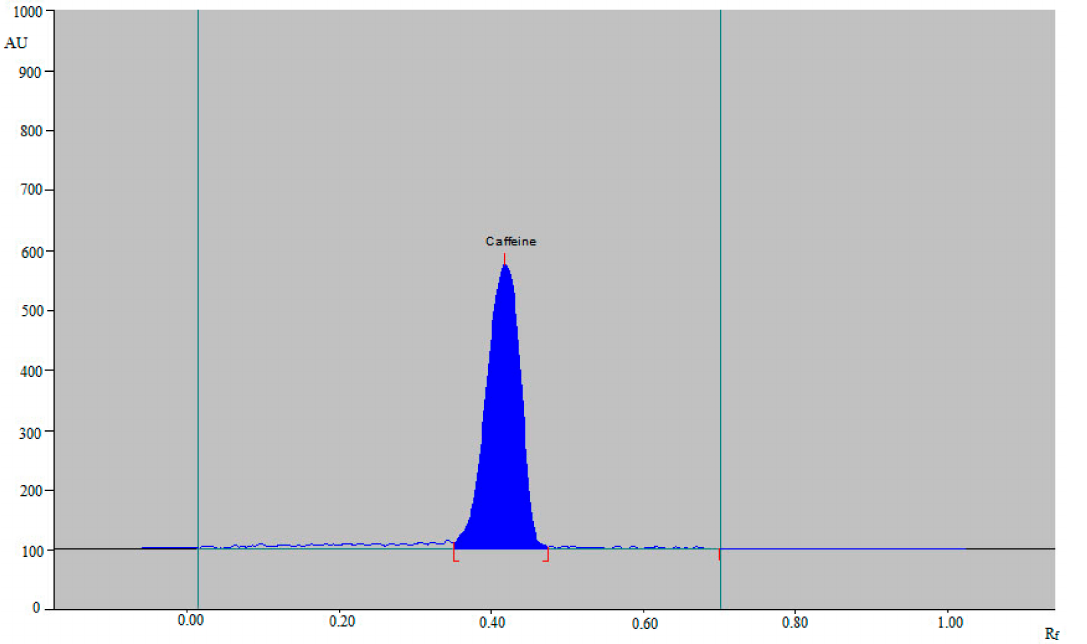
Figure 2. Representative chromatogram of standard caffeine obtained using the green HPTLC method.